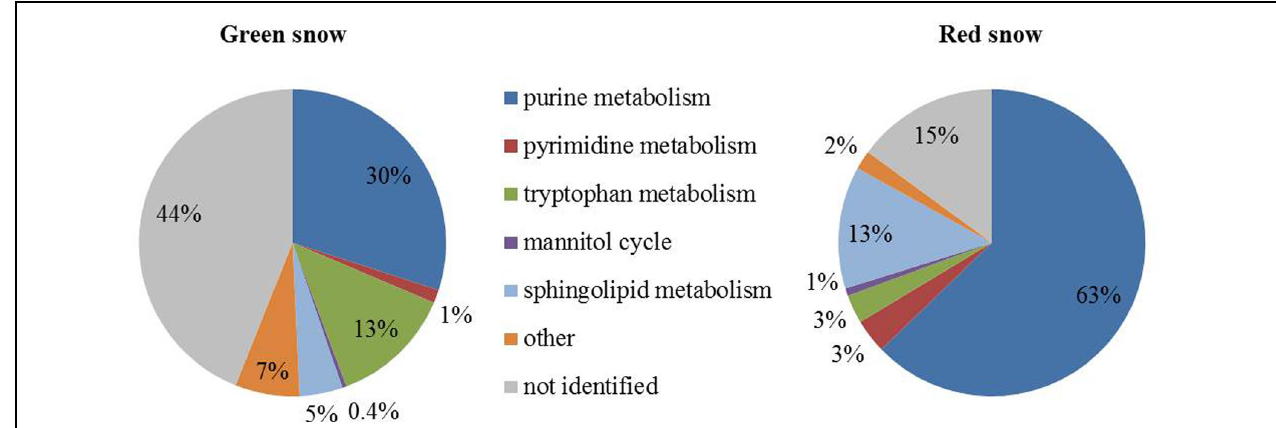
FIGURE 3 | Pie charts showing metabolomics data grouped into main metabolic pathways in green and red